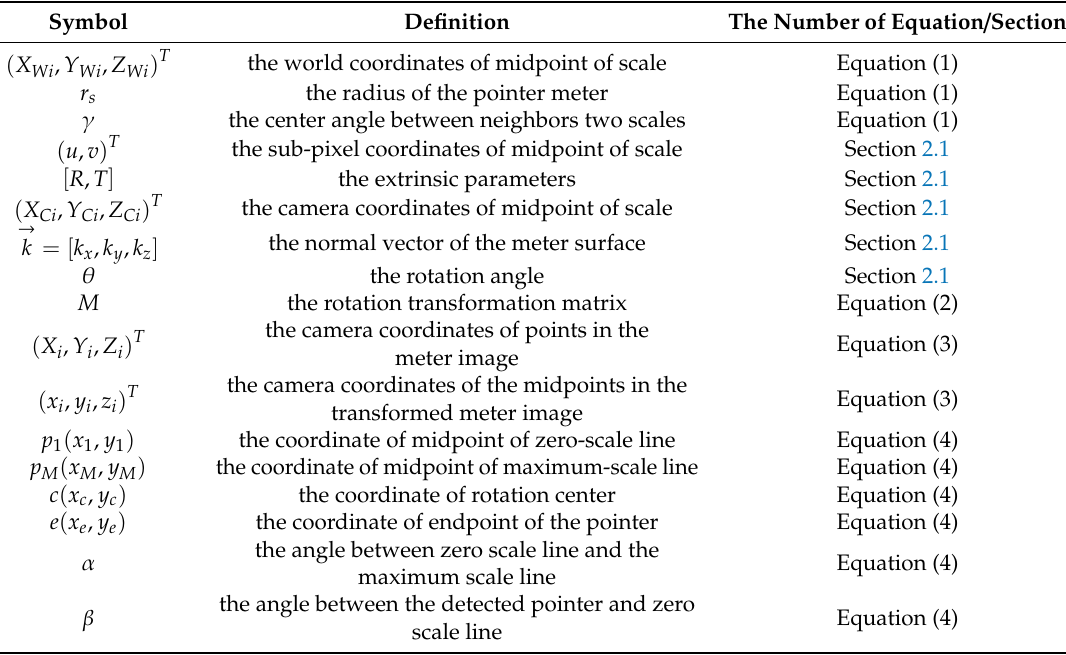
Table A2. Description of Symbols in the